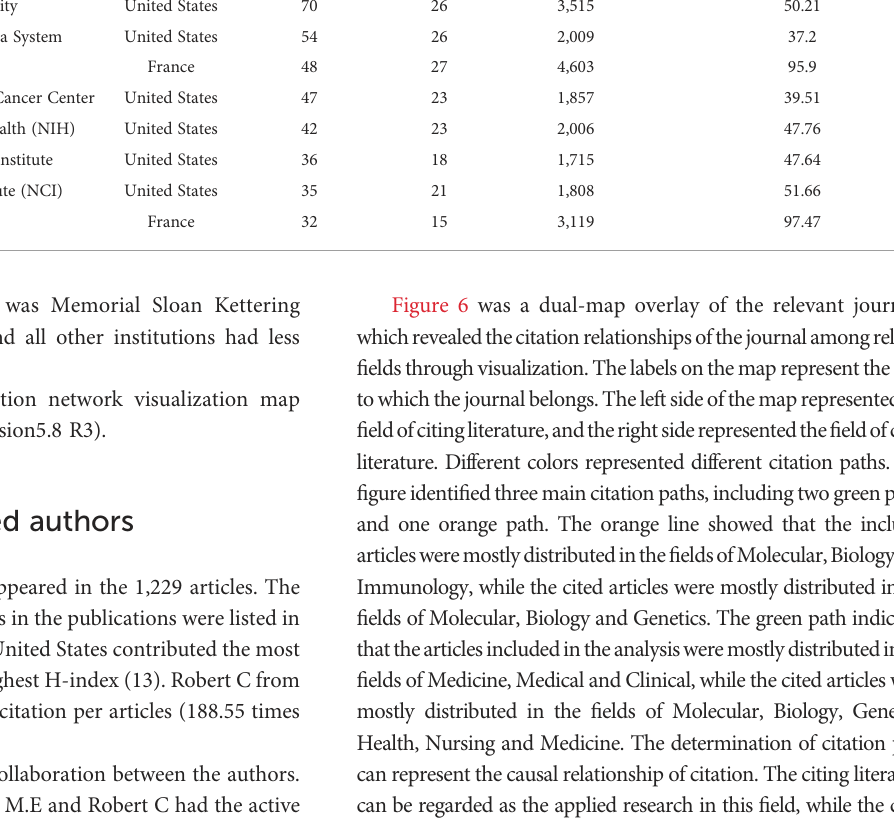
TABLE 2 The top 10 productive institutions ranked by the numbers of